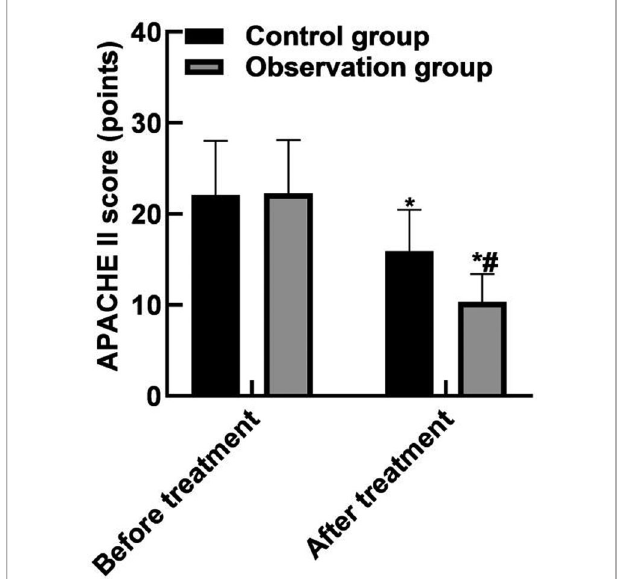
FIGURE 1 | Comparison of APACHE II scores. Note: Compared with before treatment, * P <0.05; Compared with the control group, # P